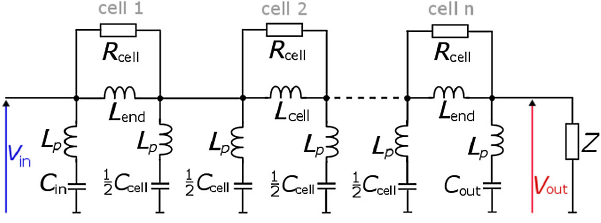
FIG. 1. The equivalent electric circuit of an n-cell transmission line kicker